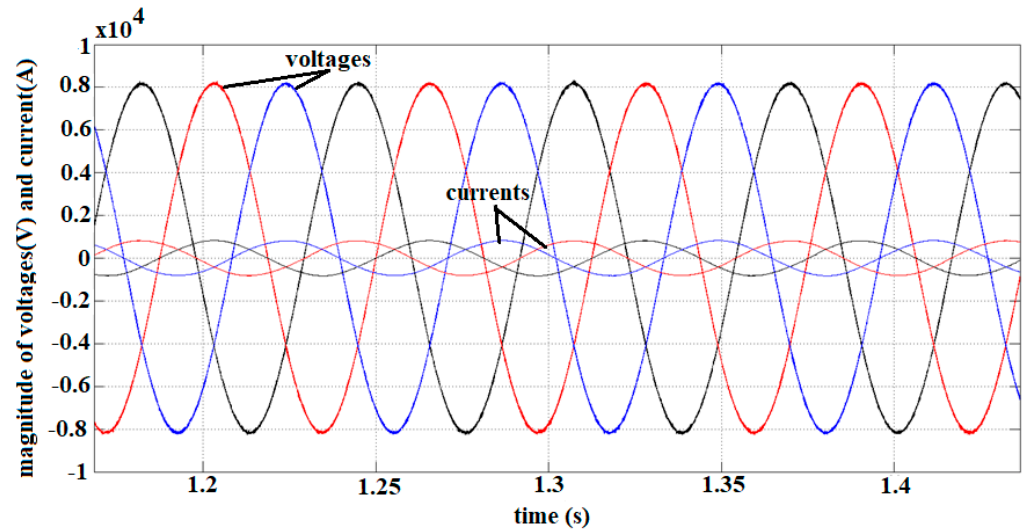
Figure 12. Hexverter’s output voltage and current waveforms.